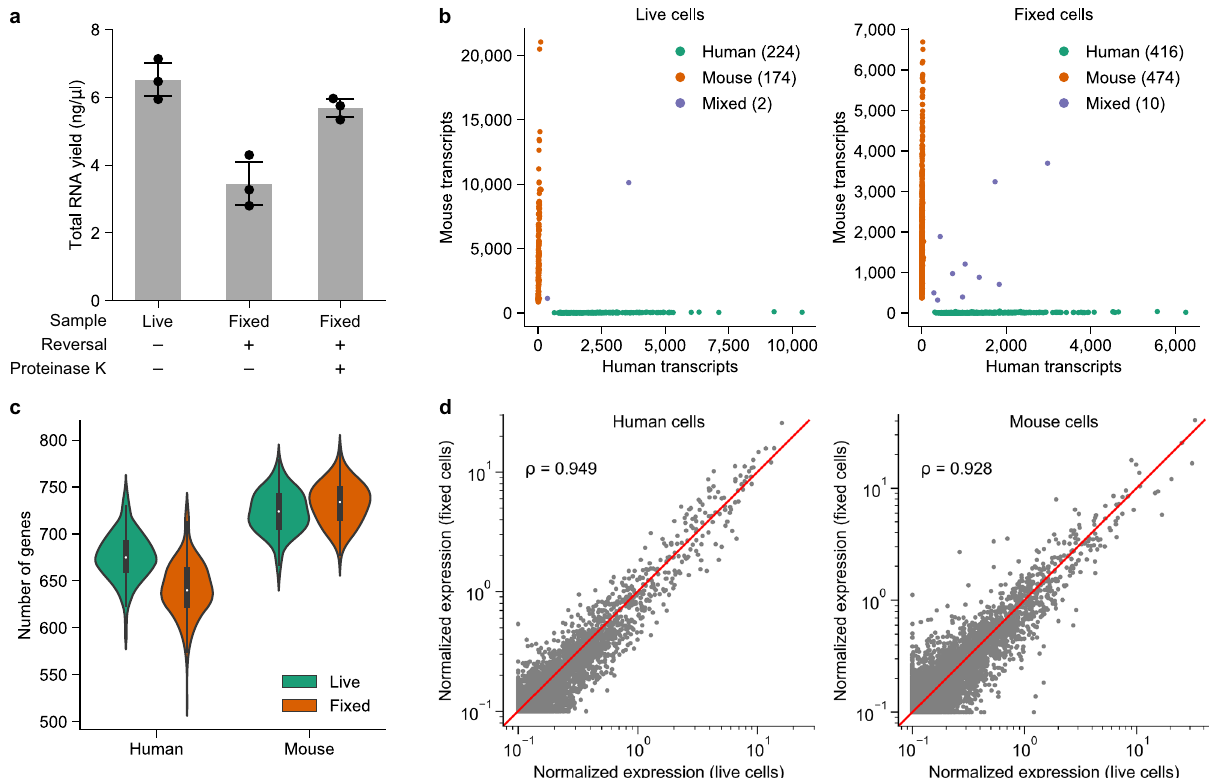
Fig. 1 Benchmarking and validation of FD-seq. a Bar plots showing total RNA yield from bulk live cells, and bulk fi xed cells that underwent cross-link heat reversal (1 h at 56 °C) with or without 40 U/mL of proteinase K. Data are presented as mean ± standard deviation. n = 3 technical replicates. b Species- mixing plots showing the single-cell capture ef fi ciency of Drop-seq and FD-seq. The multiplet rate for live cells and fi xed cells were ~0.5% and ~1%, respectively. Human BC3 cells were combined with mouse 3T3 cells at equal concentration, and processed with Drop-seq or FD-seq. See the “ Methods ” section for more details. c Violin plots and box plots showing the number of detected genes in live and fi xed cells for each species. For this analysis, only cells with at least 1500 transcripts were considered, and 1000 transcripts were randomly sampled from each single cell. The white dots inside the violin plots represent the median of the data, the black boxes represent the fi rst and third quartiles, and the black lines represent the values 1.5× the interquartile range beyond the fi rst and third quartiles. n = 157 and 164 single cells for live and fi xed human samples. n = 150 and 267 single cells for live and fi xed mouse samples. d Comparison of the normalized expression level of each gene between live and fi xed cells for each species (see “ Methods ” section). Each dot represents the average expression level of a gene, and the red line indicates the line y = x . The plots also show the Pearson ’ s correlation coef fi cient ρ of the log-normalized gene expression level between live and fi xed cells for each